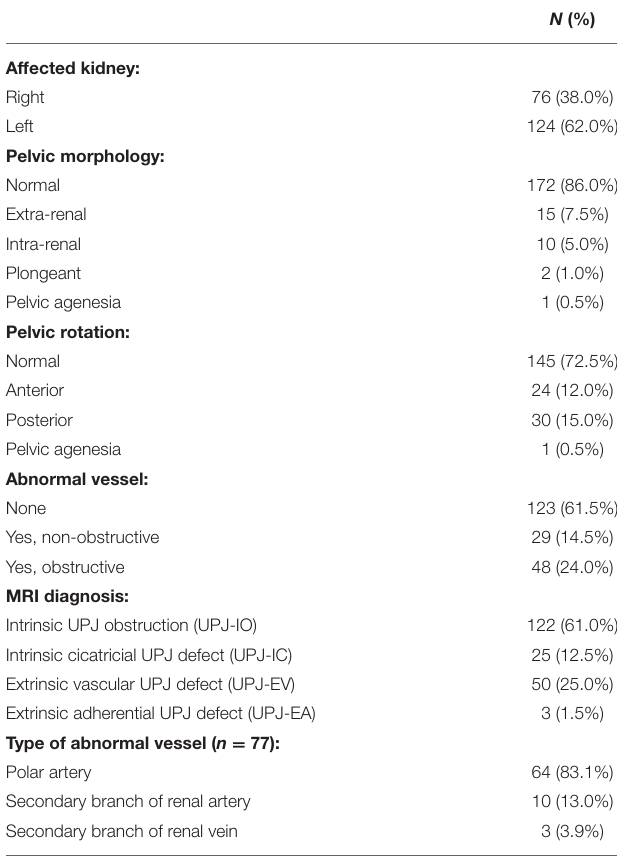
TABLE 1 | Anatomical features of the kidneys included in the study ( n =